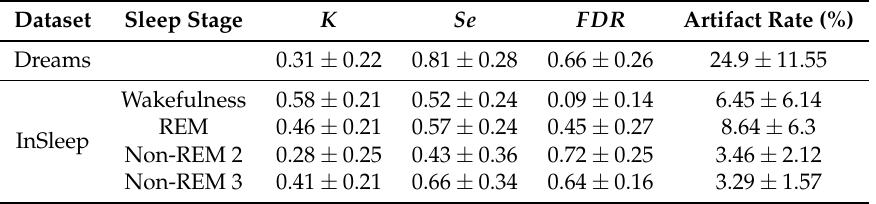
Table 6. Performance of the FASTER artifact detection